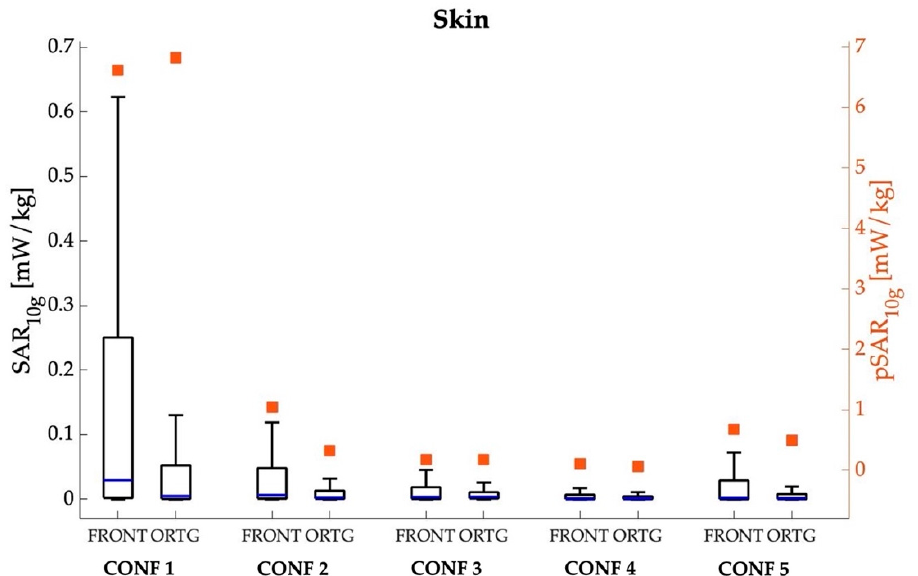
Figure 4. SAR 10g (left y -axis, box plot) and pSAR 10g (right y -axis, square symbols) in the skin tissue over the whole body for the five different examined configurations, considering the frontal and orthogonal orientations of the Ella model. The center line in the boxes is the median; the bottom and top edges are the 25th and 75th percentiles. The lower whisker extends to the minimum value, while the upper whisker extends to 1.5 times the height of the box.